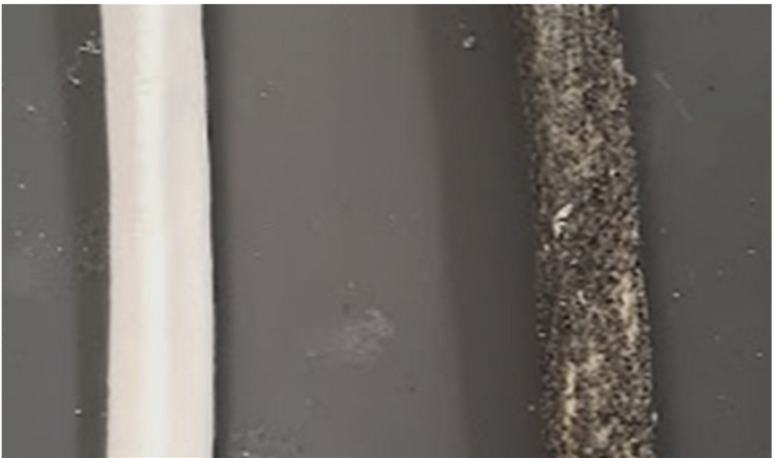
Figure 2. Photograph showing our periosteum-coated phantom bone segment ( right ) beside to a bare 3D print ( left ). Four individually cured layers produce a smooth sheath, improving behavior at joints, and controllable